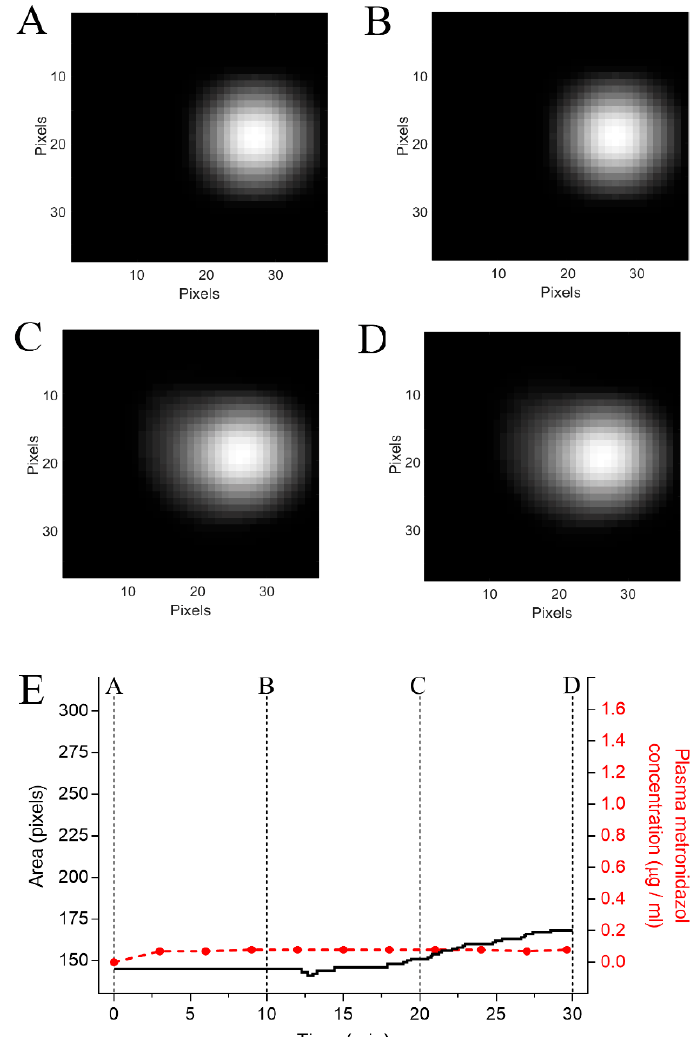
Figure 5. Pharmacomagnetography monitoring of the coated magnetic tablet after administration of omeprazole. ( A ) Magnetic images at t = 0 min, ( B ) t = 10 min, ( C ) t = 20 min, and ( D ) t = 30 min after coated magnetic tablet administration. ( E ) Quantification of the magnetic area and metronidazole concentration, the dotted lines indicate the time points in which A, B, C, and D were Table 3. Comparison of pharmacokinetic parameters before (control) and after omeprazole administration to healthy volunteers. Data are expressed as the mean ± SD and median. NA= not available * p < 0.05 vs. control; ** p < 0.001.